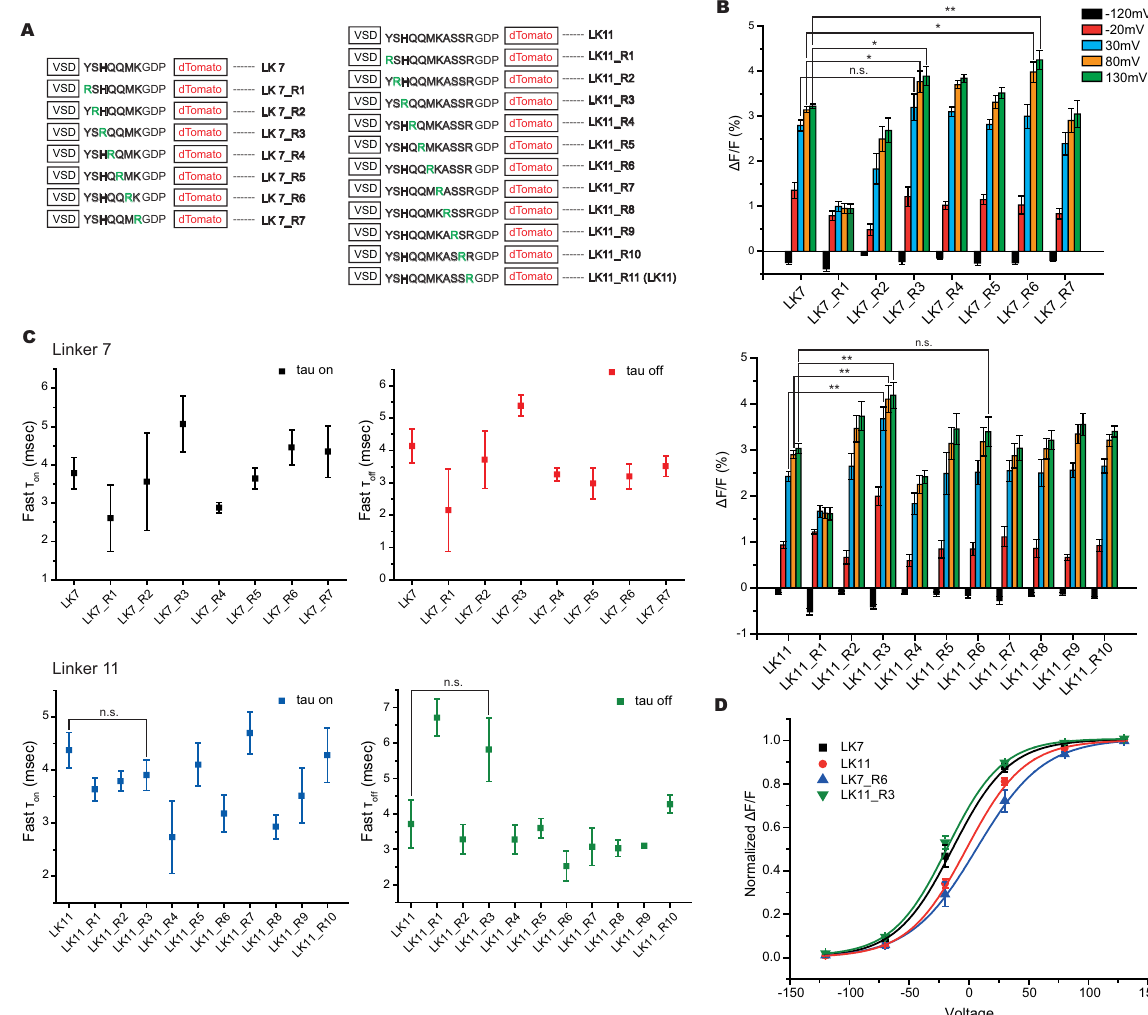
Figure 2. Introduction of positive charges into the linker segment improved the voltage-dependent optical signal. ( A ) List of constructs showing the position of the positively charged amino acid, arginine, in the LK7 construct (left) and the LK11 construct (right). The arginine mutation is shown in green. ( B ) Average optical responses to hyperpolarization of the plasma membrane to − 120 mV (black), depolarization of the plasma membrane to − 20 mV (red), depolarization to 30 mV (blue), depolarization to 80 mV (orange), and depolarization to 130 mV (green). ( C ). Fast time components of all the constructs presented in A. ( D ) Boltzmann fit of the normalized fluorescence change for the two best constructs in B. LK7 and LK11 are replotted for ease of comparison. Asterisks in B indicate statistically significant differences between means compared (n.s. no significant difference, * p < 0.05, ** p < 0.01). (n ≥ 4 for all